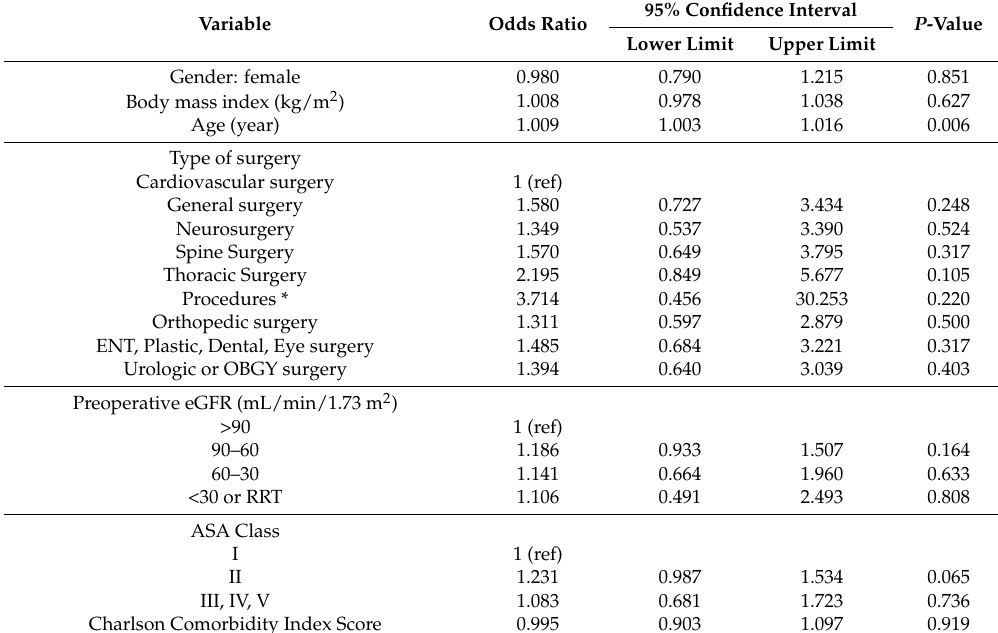
Table A1. Univariate logistic regression analysis for all-cause 30-day mortality after surgery. 95% Confidence Variable Odds Ratio